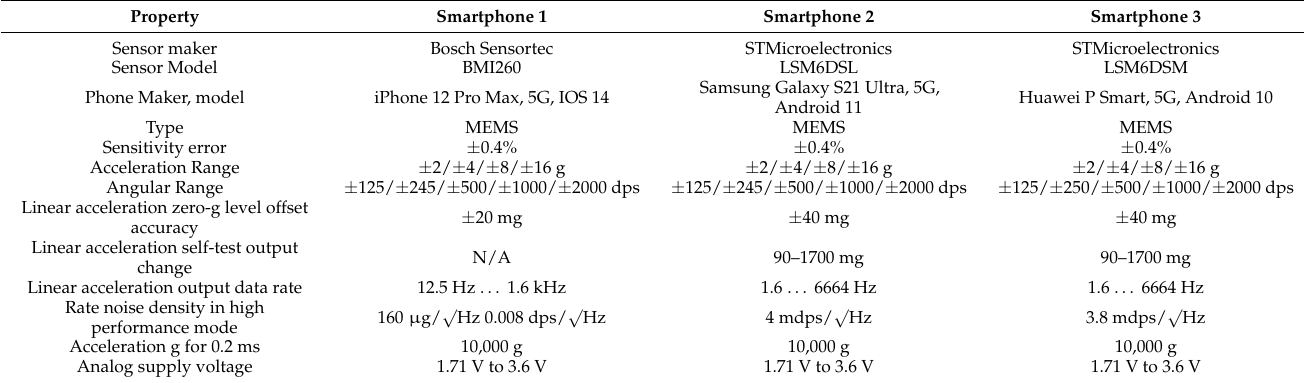
Table 1. Smartphone accelerometer